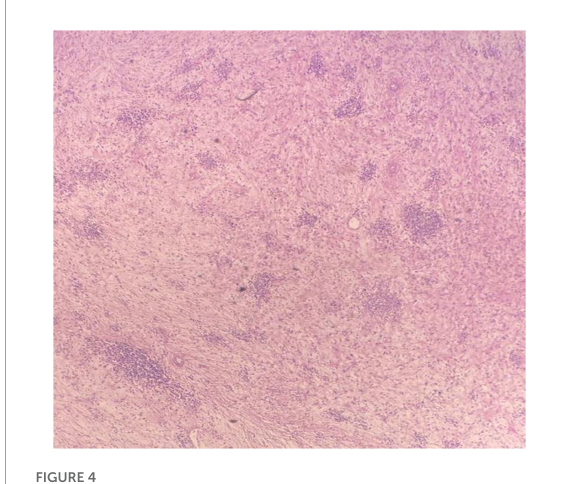
FIGURE4 Microscopic image of loosely arranged spindle cells growing in haphazardly arranged fascicles, interspersed by abundant chronic inflammatory cells, LPF.